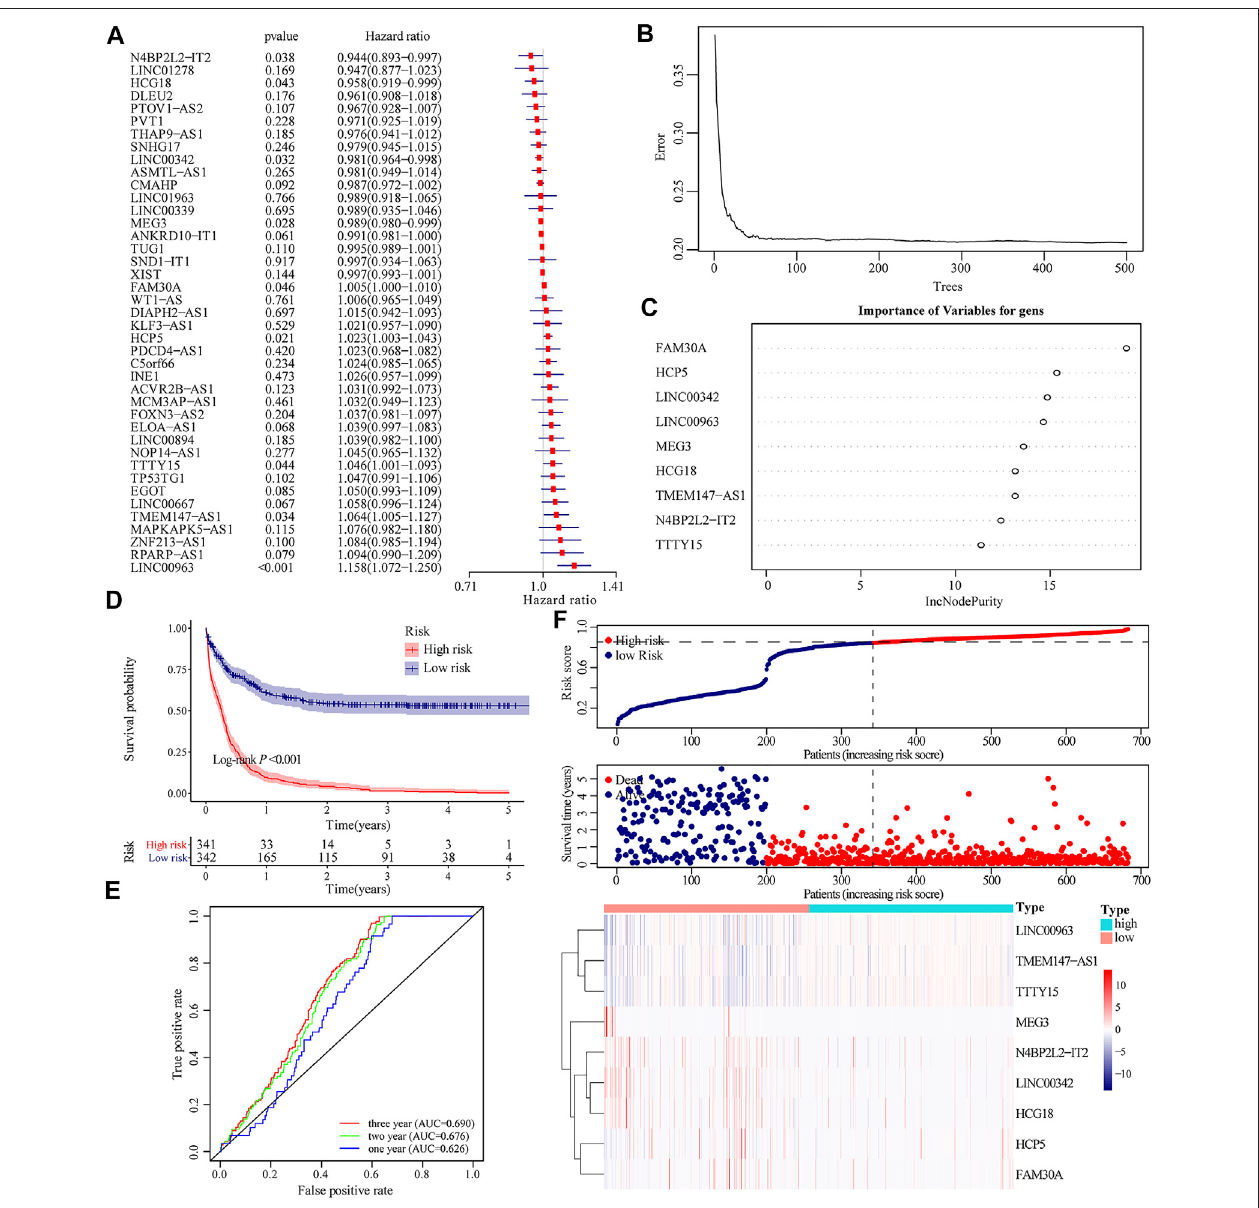
FIGURE 2 | Construction of m6A-related lncRNA-based prognosis model. (A) Univariate Cox regression demonstrating that the expression level of nine lncRNAs were dramatically associated with the prognosis of AML patients. (B) Generating a random forest model according to the expression of m6A-related lncRNAs. (C) Weights of nine different m6A-related lncRNAs in the random forest model. (D) Kaplan – Meier curve assessing the impact of risk score on the OS rate of AML patients in TCGA and GEO database. (E) Time-dependent ROC curve evaluating the accuracy of the prognostic model. (F) Risk score distribution of AML patients in TCGA and GEO databases, and the heatmap shows the patient ’ s survival status and expression of characteristic genes.